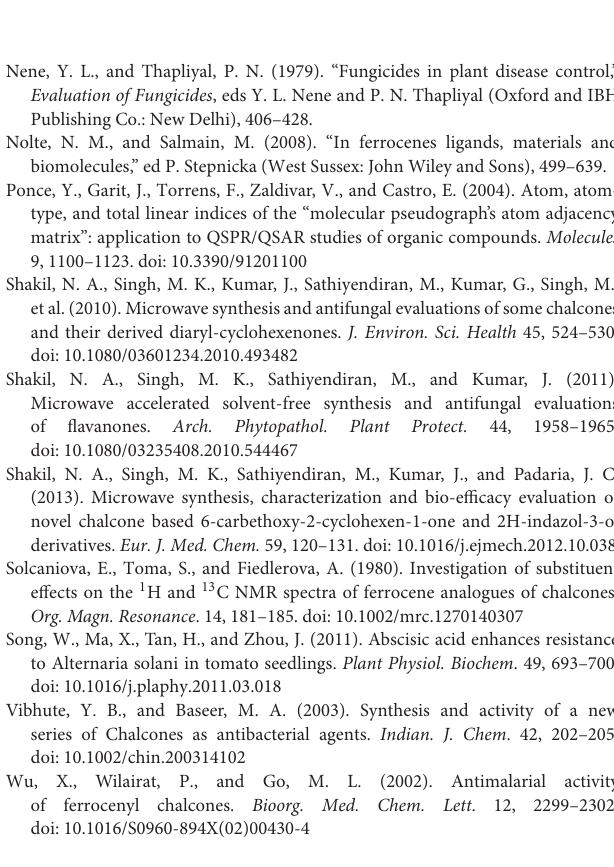
Supplementary Data Sheet 3 | Enlarge view of NMR